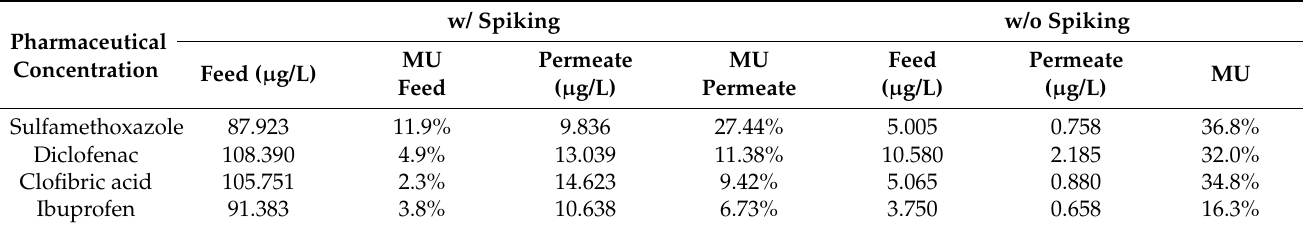
MU: Measurement uncertainty. MU represents the measurement error or deviation from standard values in HPLC (with spiking) or MS (without spiking) measurement methods.